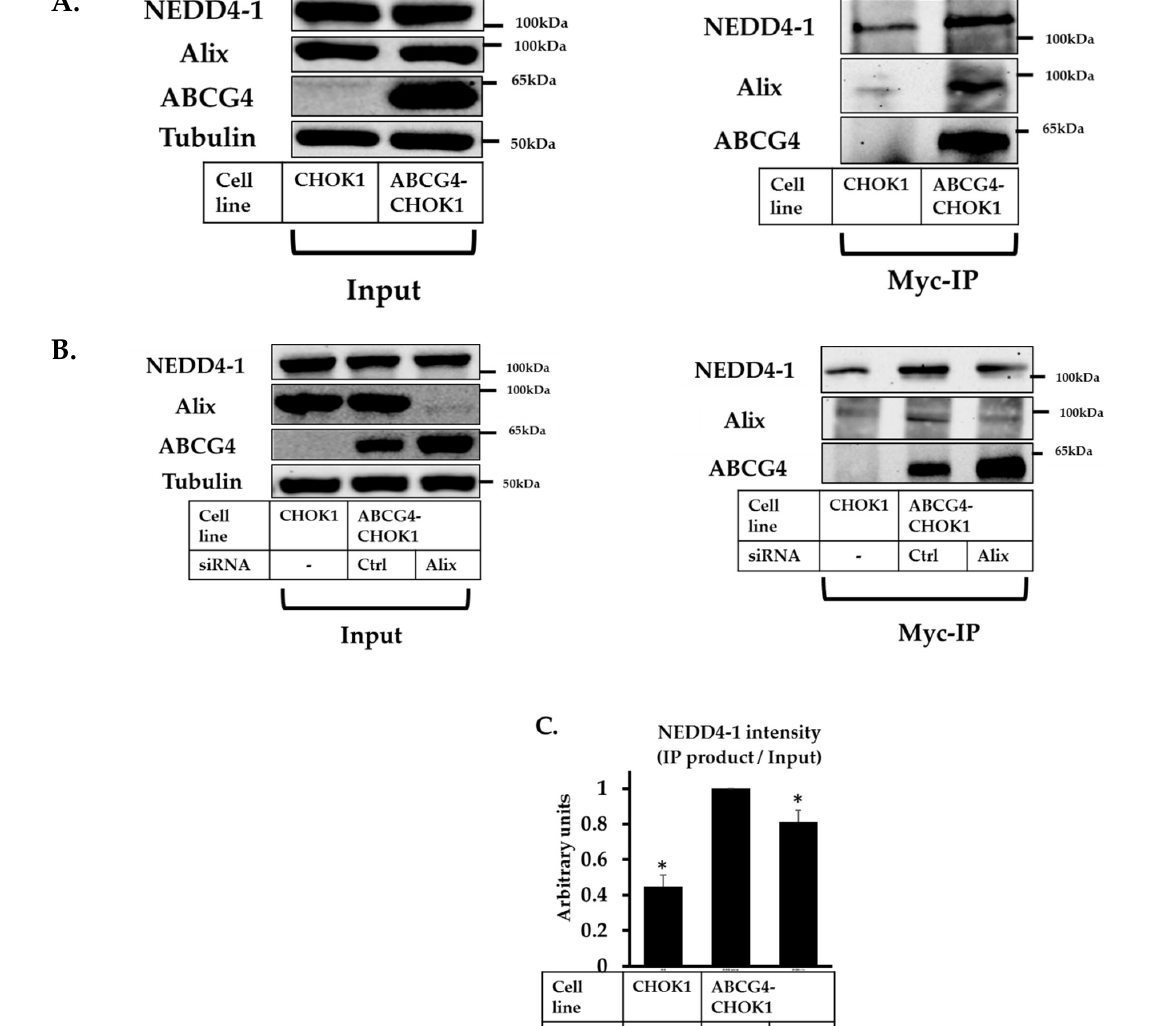
Figure 7. Apoptosis-linked gene 2-interacting protein X (Alix), Neural precursor cell-expressed developmentally downregulated gene 4 (NEDD4-1) and ABCG4 co-immunoprecipitation (co-IP). ( A ) IP of CHOK1 and ABCG4-CHOK1 cell lysates, immunoprecipitated with anti-myc antibody. Results are representative of two independent experiments ( B ) IP of CHOK1 and ABCG4-CHOK1 cell lysates after knockdown of Alix (72 h), immunoprecipitated with anti-myc antibody ( C ) represents quantification of NEDD4-1 in IP product, with/without Alix knockdown, relative to NEDD4-1 in whole cell lysate (Input) from three independent data points (* indicates p < 0.05 relative to the ABCG4-CHOK1 control transfected cells).